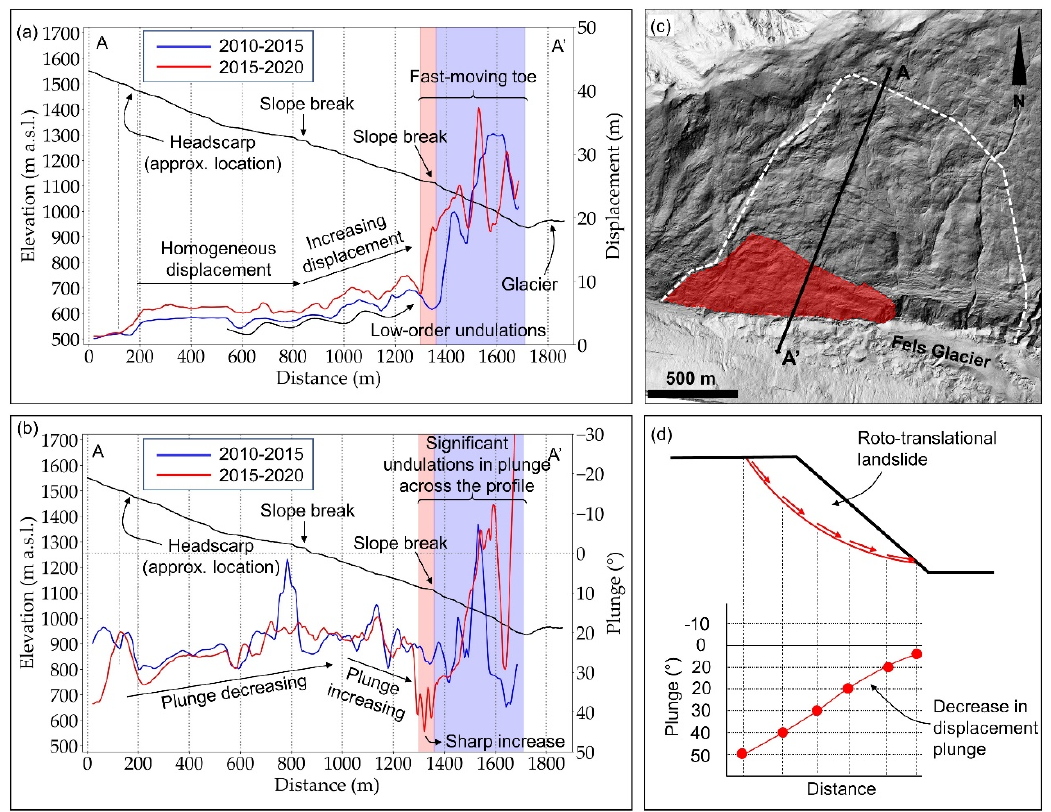
Figure 8. Example of profiles extracted from the ST dataset, and comparison with surface elevation from the ALS dataset. ( a ) Cumulative displacement magnitude profile as a function of elevation. Note the small-scale undulations in the cumulative displacement profile and the sharp increase in the fast-moving toe. ( b ) Displacement plunge profile as a function of elevation. Note the overall decrease in plunge in the upper slope and the increase in the central-lower slope. In ( a , b ), the blue and red bars denote, respectively, the extent of the fast-moving toe in the 2010–2015 time window and the upslope extent observed in the 2015–2020 time window. ( c ) Location of the profile in ( a , b ), roughly parallel to the displacement direction (trend). ( d ) Conceptual representation of the changes in displacement plunge in a simple roto-translational landslide.